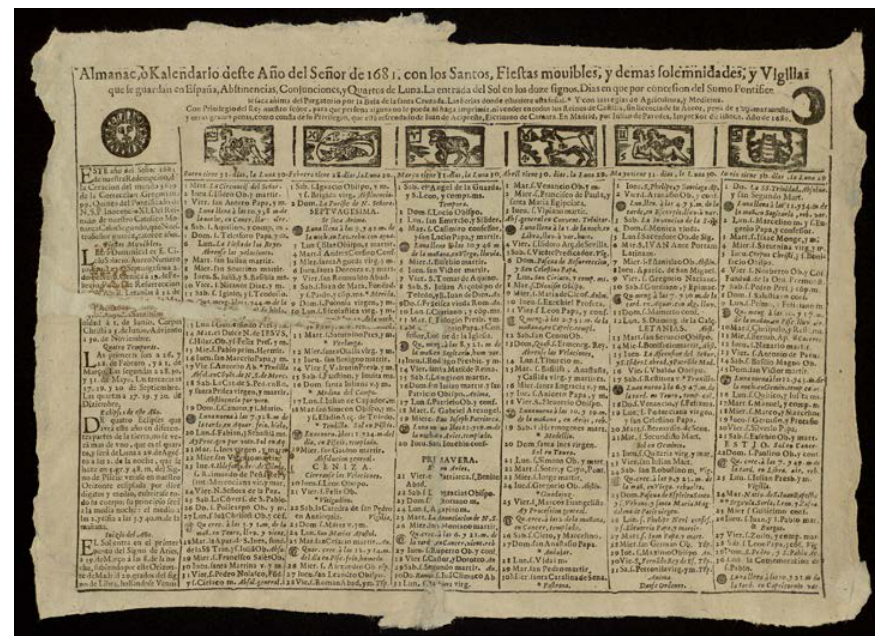
Figure 1 – Almanaque o calendario deste año del Señor de 1681 (1680), Madrid, Julián de Paredes. Courtesy of Archivo Municipal de